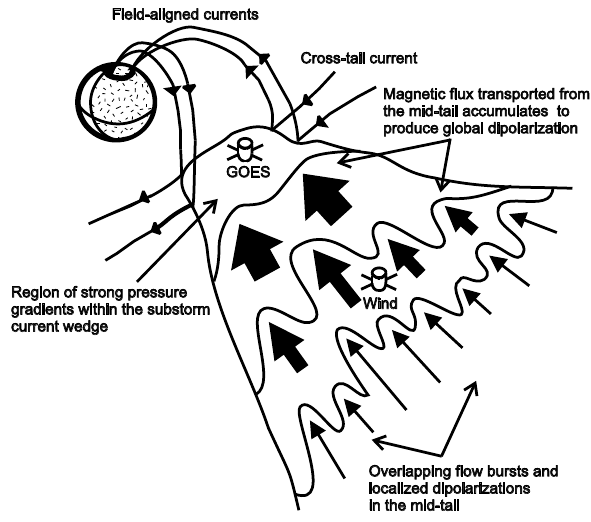
Fig. 13. Diagram illustrating the development of the substorm cur- rent wedge through overlapping flow bursts and localized dipolar- izations. In this scenario, dipolarization of the entire magnetotail is a piecewise process resulting from the accumulation of magnetic flux transported by spatially and temporally overlapping flow bursts. The pressure gradients associated with these flow bursts are inte- grated by the inner magnetosphere to produce the substorm current